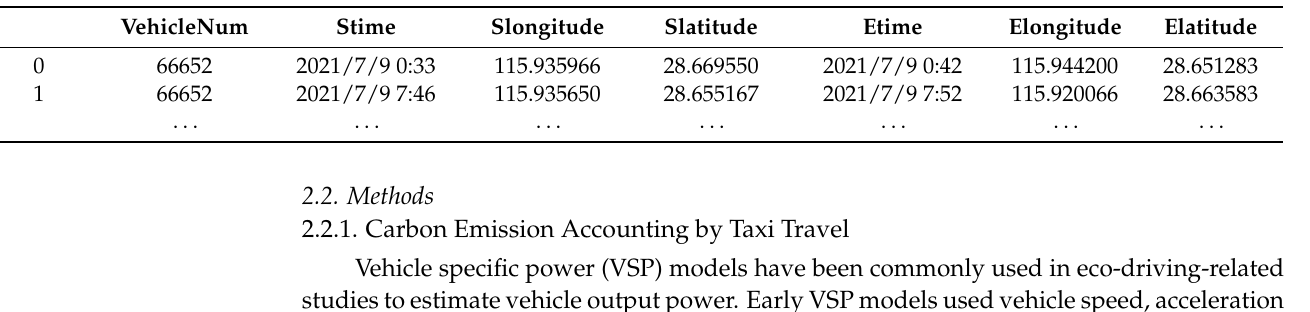
Table 3. Taxi trip record